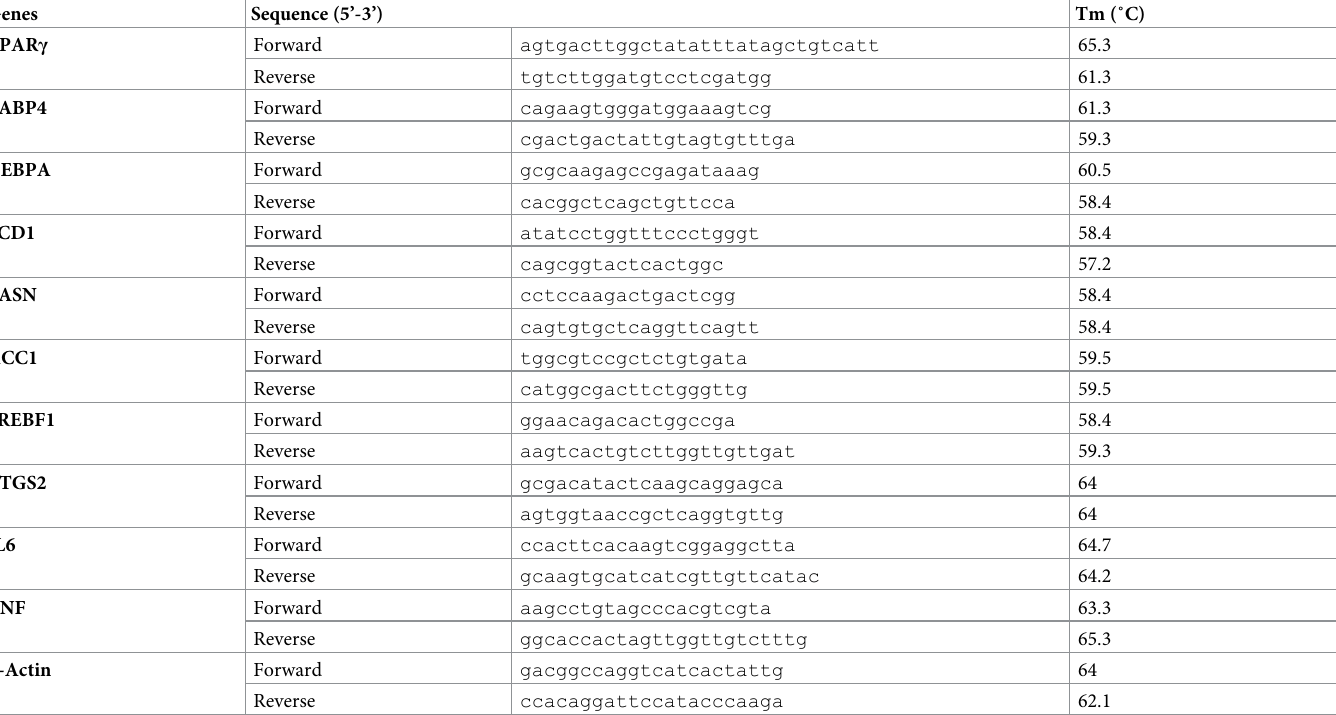
Table 1. Primer sequence used in this